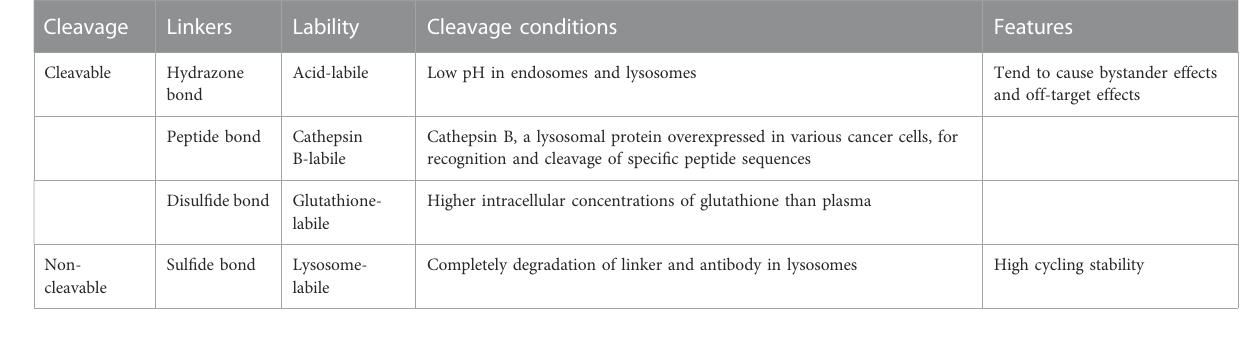
TABLE 2 Types of toxins used in